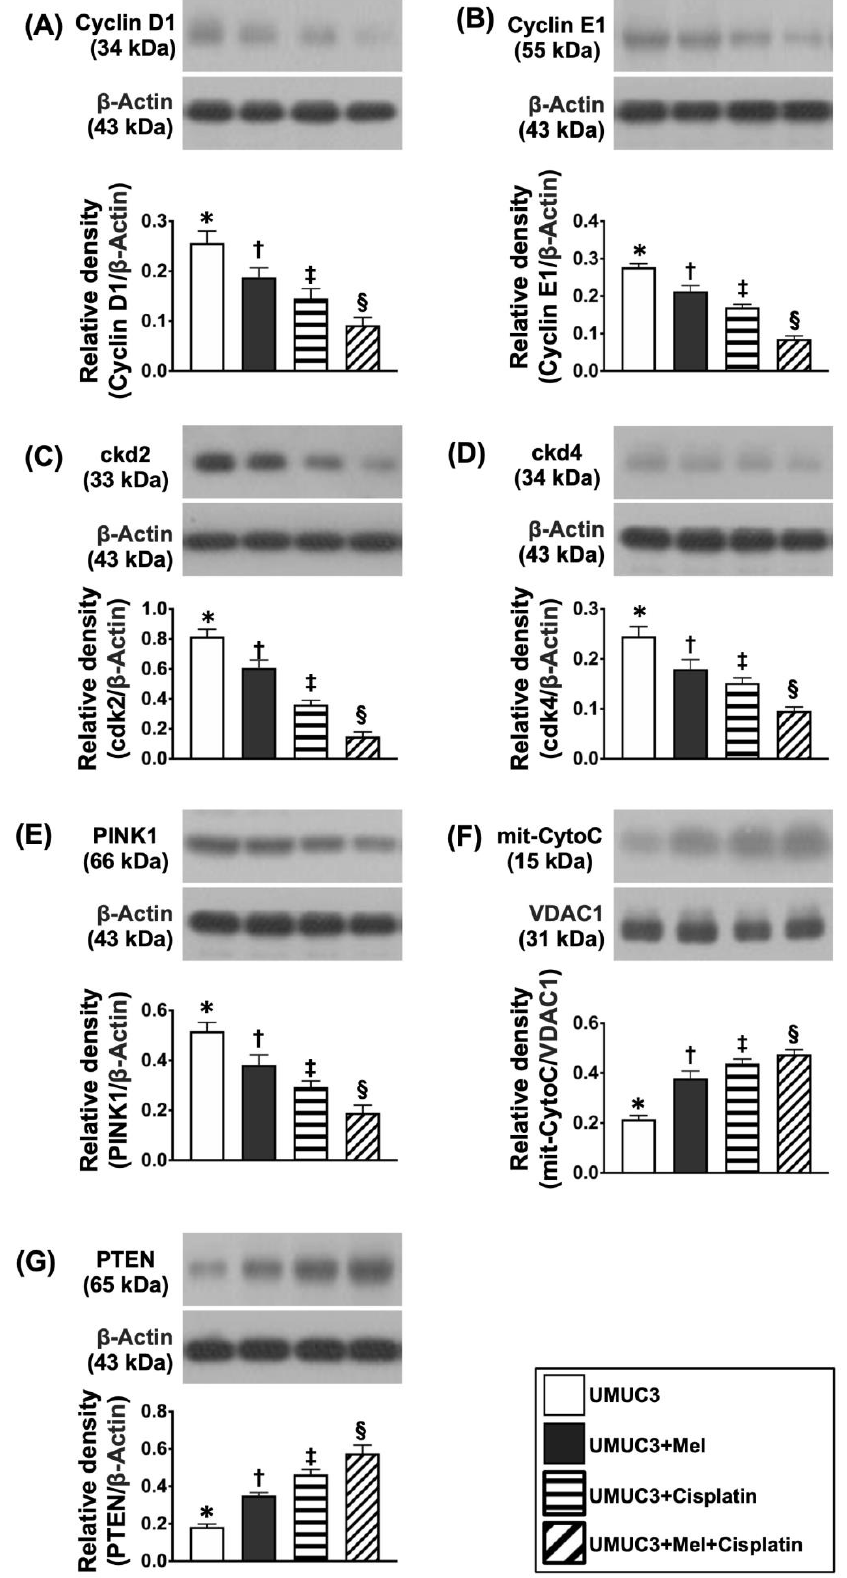
Figure 11. Protein expressions of cell cycle biomarkers on day 28 after UMUC3 engraftment into nude mouse backs. ( A ) Protein level of cyclin-D1, * vs. different symbols (†, ‡, and §), p < 0.0001. ( B